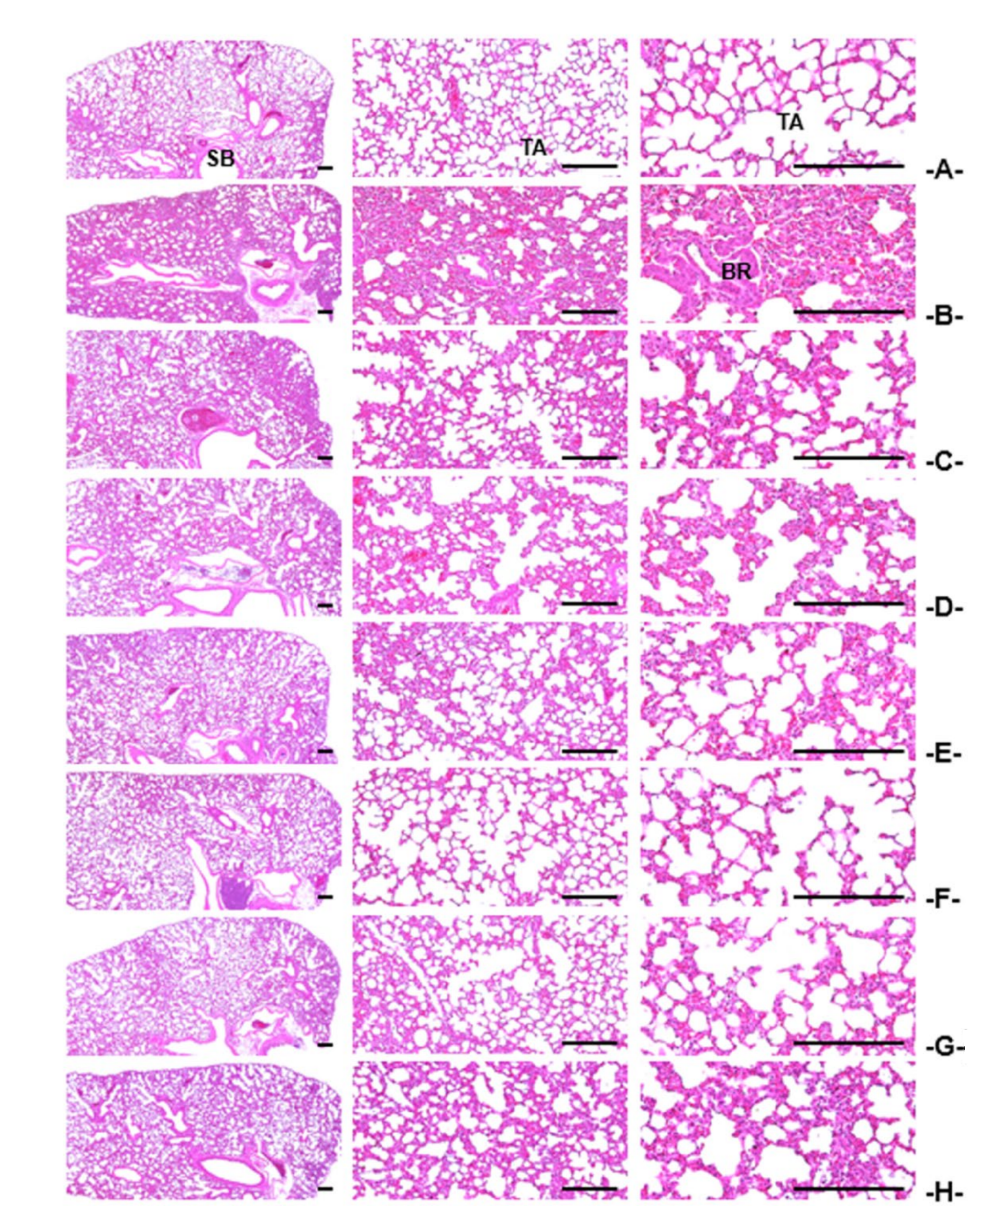
Figure 3. Changes in the histological features of lung in mice. Different treatment groups as followed by the ( A ) intact vehicle control, ( B ) NH 4 OH control, ( C ) TB 50 mg/kg + NH 4 OH, ( D ) AR 400 mg/kg + NH 4 OH, ( E ) KOG 400 mg/kg + NH 4 OH, ( F ) SKOG 400 mg/kg + NH 4 OH, ( G ) SKOG 200 mg/kg + NH 4 OH, and ( H ) SKOG 100 mg/kg + NH 4 OH. Scale bar = 120 µ m. SB: Secondary bronchus; TA: Alveolus-terminal bronchiole; TB: Theobromine; ASA: Alveolar surface area; BR: